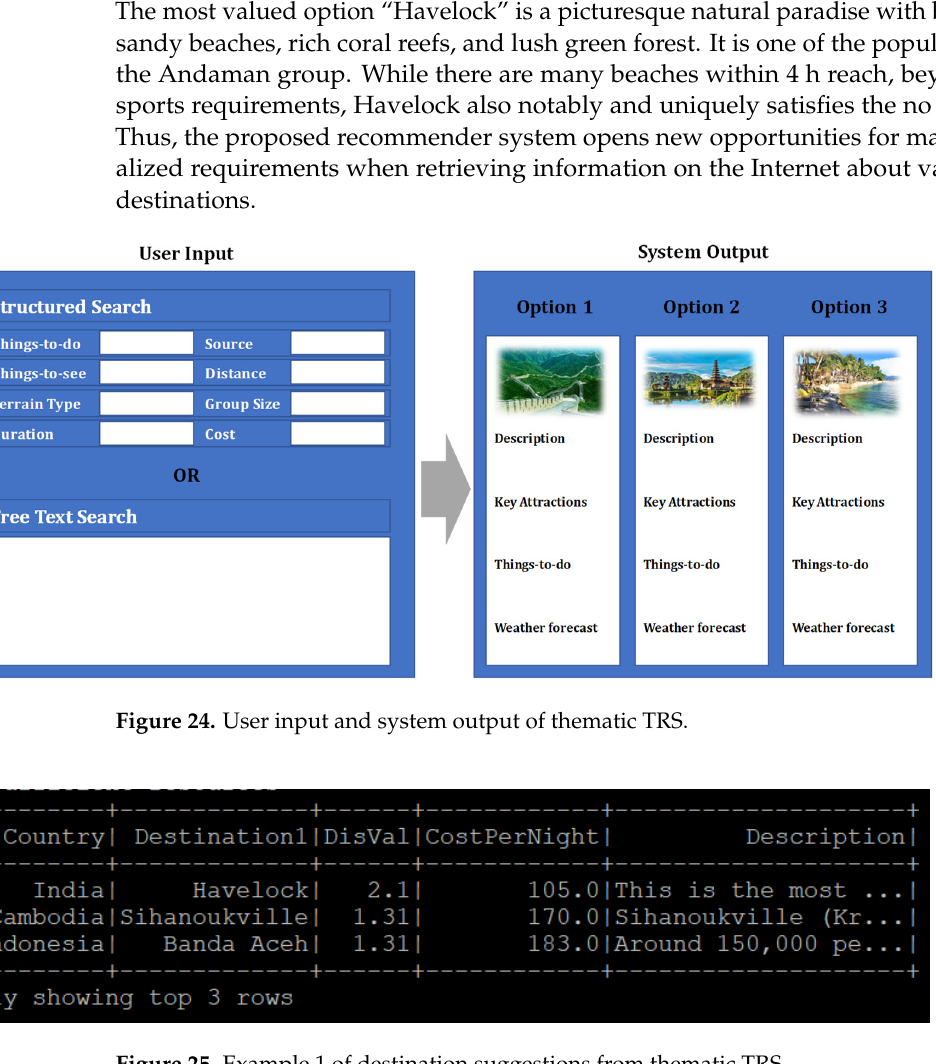
Figure 24. User input and system output of thematic TRS.